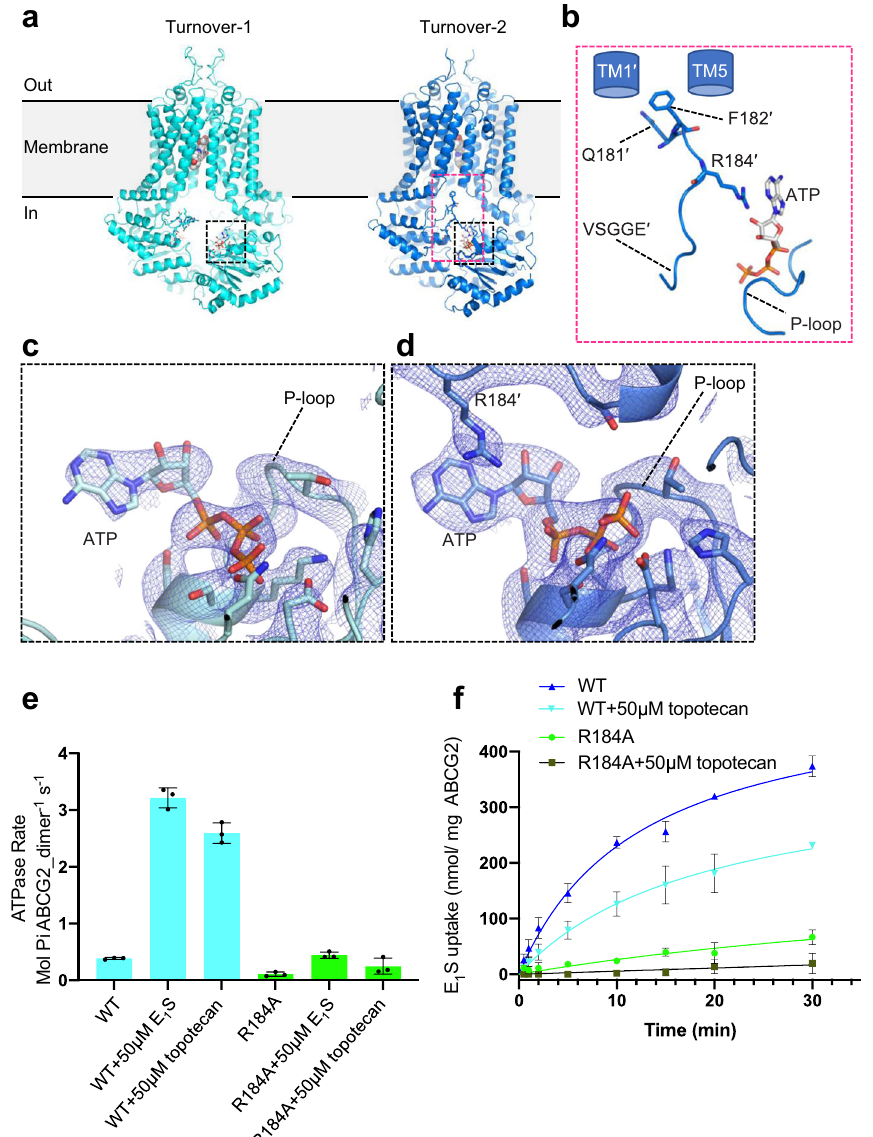
Fig. 3 Domain interfaces and the role of R184. a Ribbon diagrams of topotecan-bound turnover states. ATP is shown as sticks, topotecan is shown as spheres. Dashed black and red boxes show domain interfaces with close-up views in b – d . b Close-up view of domain interface in turnover-2 conformation. TM1 ’ and TM5 are schematically shown as blue cylinders. P-loop, X-loop, and signature motif (VSGGE) are shown in cartoon mode. ATP and key side chains involved in surface interactions are shown as sticks. c and d Close-up views of ATP-binding sites of turnover-1 and turnover-2 states, as indicated in a . ABCG2 is shown as a ribbon diagram, key residues and bound ATP are shown as sticks and labeled. Non-symmetrized EM density maps are shown as blue mesh. e ATPase activity of liposome-reconstituted wild-type and mutant ABCG2 (R184A) in the presence and absence of 50 μ M E 1 S or 50 μ M topotecan. Data are presented as mean rates ± s.d. The experiment was performed 3 times independently with the same batch of liposomes ( n = 3). Error bars depict s.d. f ABCG2-catalyzed E 1 S transport into proteoliposomes by wild-type ABCG2 or R184A variant in the presence or absence of 50 μ M topotecan. Data are presented as mean values± s.d. The experiment was performed 3 times independently with the same batch of liposomes ( n = 3). Error bars depict s.d. Source data are provided as a Source Data fi